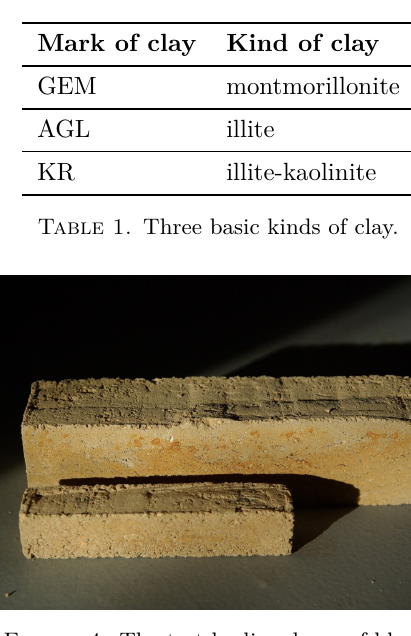
Figure 4. The test bodies shape of